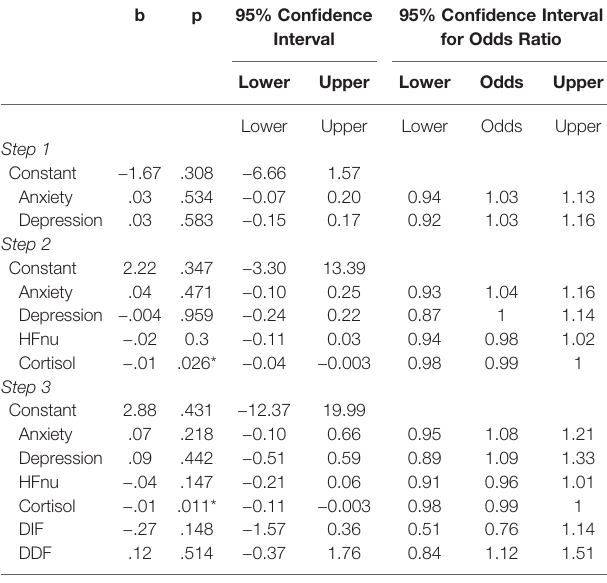
TABLE 6 | Summary of hierarchical logistical regression analysis predicting the presence of ulcerative colitis (UC) (95% BCa bootstrap con fi dence intervals based on 5,000